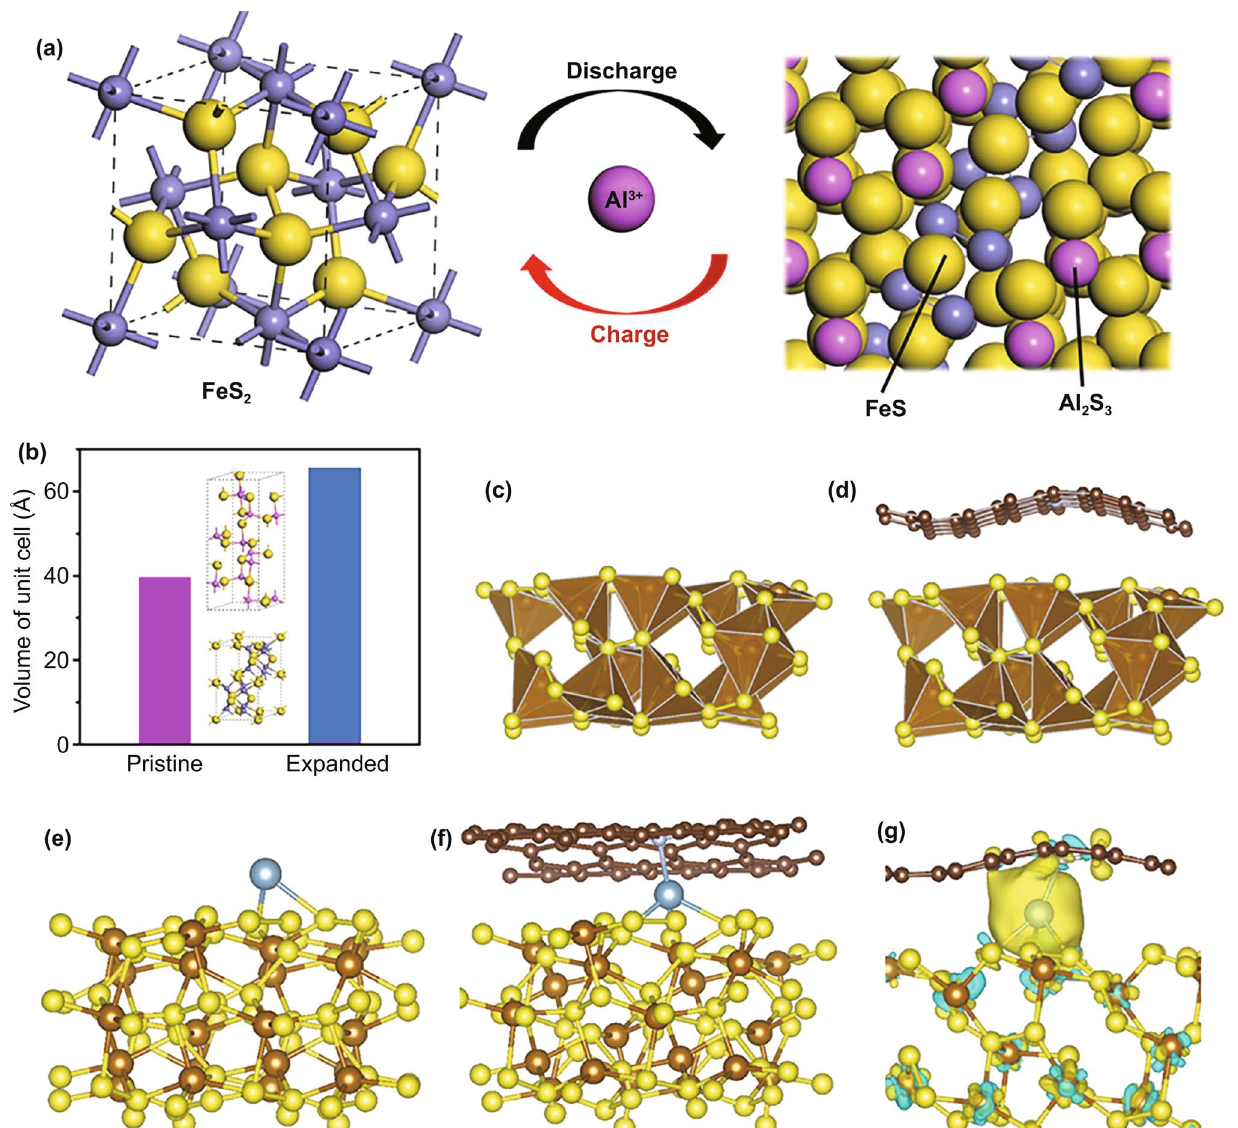
Fig. 3 a Schematic process of the charge–discharge process toward AIBs. b Simulation of the volume expansion of the FeS 2 in a unit cell. c‑d Feasible models for optimal FeS 2 and adsorption sites of FeS 2 on N–C. e–f Feasible models for optimal adsorption sites of Al ion on FeS 2 and between the N–C and FeS 2 . g Different charge density of Al ion between N–C and the FeS 2 , the isosurface value is set to be 0.05 e Å −3 . The blonde, brown, nigger brown, and blue balls represent S, Fe, C, and Al